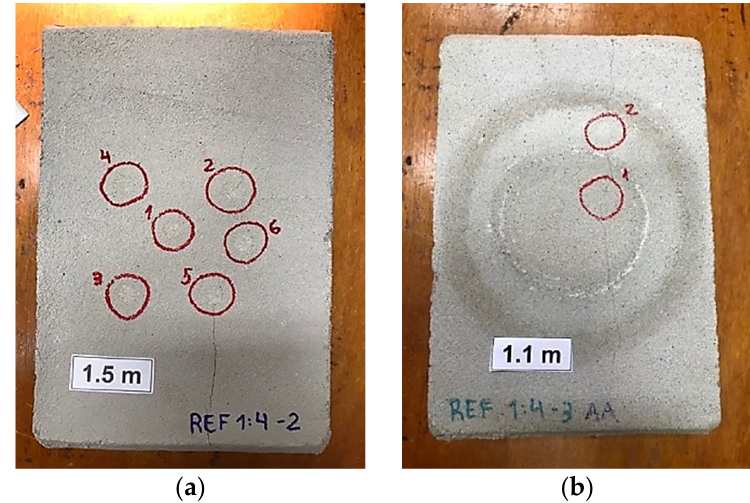
Figure 6. Resistance to impact at first crack: ( a ) before and ( b ) after ageing—REF 1:4.